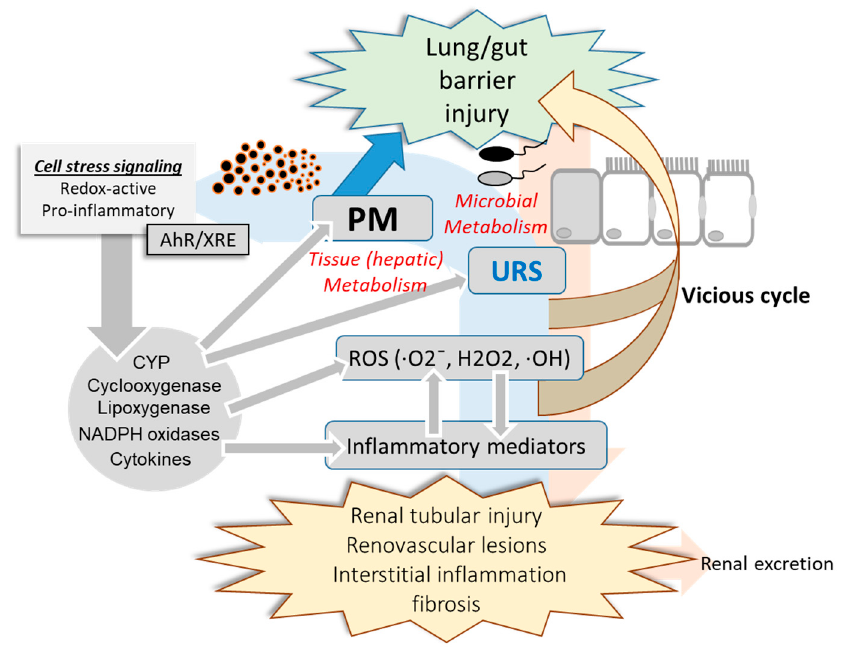
Figure 3. PM-induced alteration in mucosa-kidney axis. PM-insulted mucosal barrier allows the translocation of PM, uremic retention solutes (URS), and their metabolites which can have detrimental effects on the mucosa-kidney axis via stress signaling including AhR-linked pathways. Moreover, invasive microbes and harmful metabolites from the altered microbiota community can contribute to the systemic and renal inflammation during PM exposure. In addition to renal distress, reactive oxygen species (ROS), inflammatory mediators and the circulating xenobiotic agents including PM components and URS injure the mucosal barrier integrity in a feedback way.